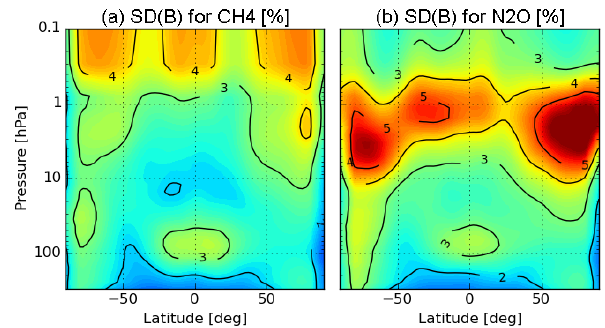
Figure 2. Standard deviation of the B matrix estimated by the en- semble method for CH 4 (left) and N 2 O